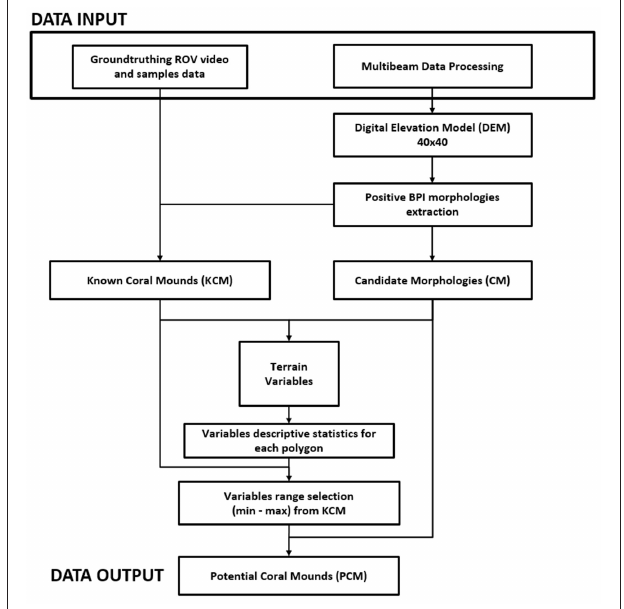
FIGURE 2 | Conceptual model of the analysis performed for the Geomorphometric proxies